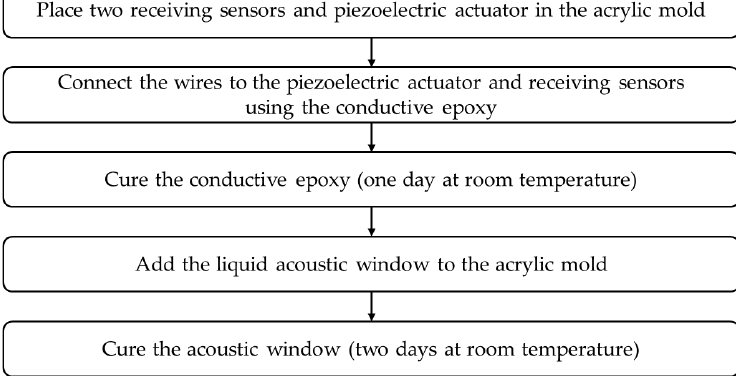
Figure 2. Fabrication process of the multilayer acoustic absorber.